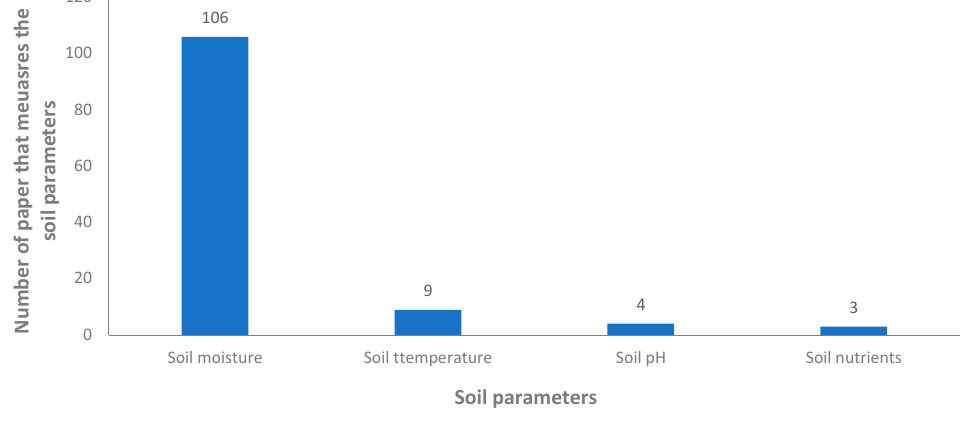
Figure 11. Monitored soil parameters in all the evaluated papers.